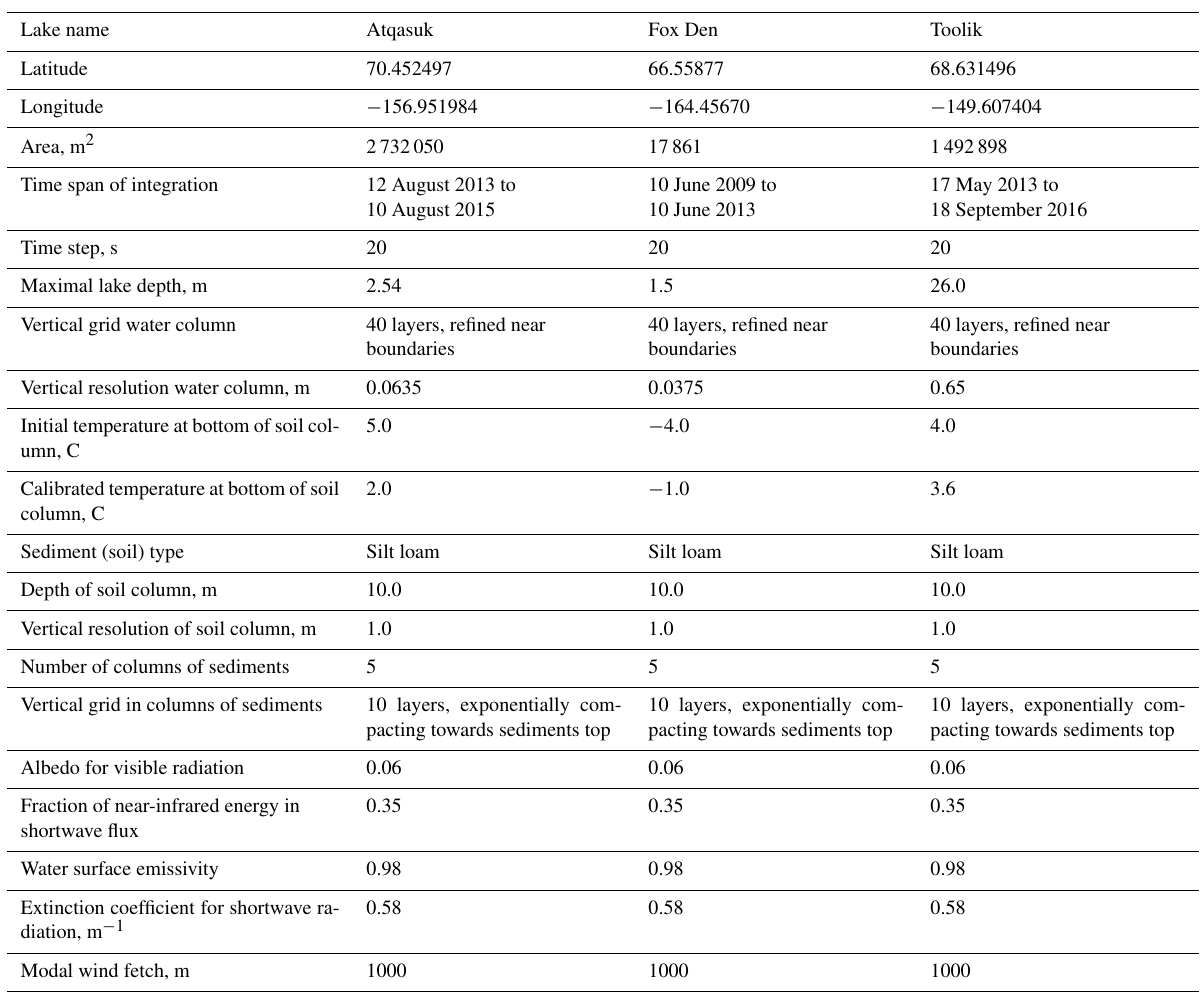
Table 1. Parameters of baseline lake